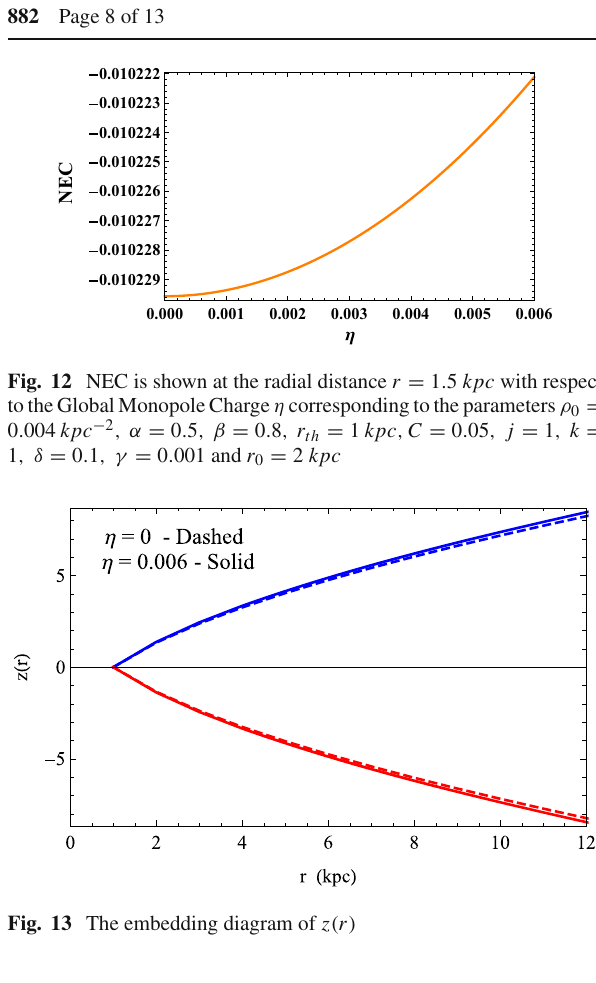
of parameters ρ 0 = 0 . 004 kpc − 2 , α = 0 . 5 , β = 0 . 8 , r th = 1 kpc , C = 0 . 05 , j = 1 , k = 1 , δ = 0 . 1 , γ = 0 . 001